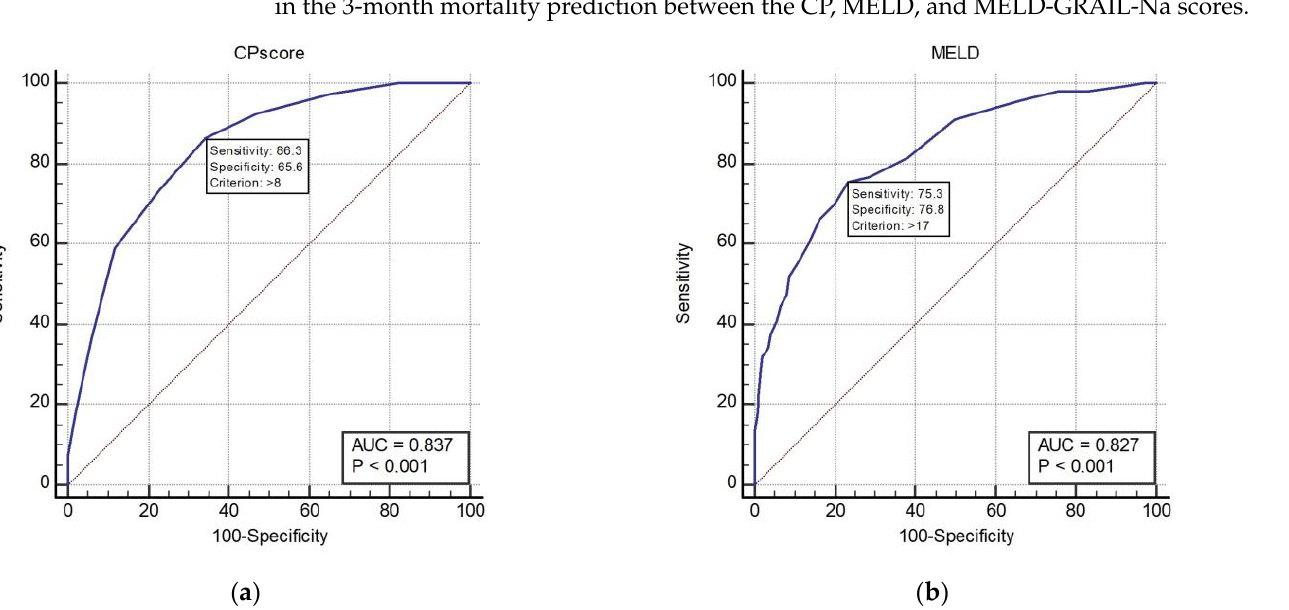
( d ) Figure 2. Receiver operating characteristic curves (ROC) and area under the ROC (AUROC) of pa- tients with total cirrhosis for 3 - month mortality. ( a ) CP score for 3 - month mortality, 0.837 (95% CI, 0.815–0.857); ( b ) MELD for 3 - month mortality, 0.827 (95% CI, 0.805–0.848); ( c ) MELD - GRAIL - Na for 3 - month mortality, 0.835 (95% CI, 0.814–0.856); ( d ) comparison of AUROC for 3 - month mortality between the CP, MELD, and MELD - GRAIL - Na scores. 3.5.3. One - Month Mortality Prediction in Patients with CP Classes B and C The AUROCs of the CP, MELD, and MELD - GRAIL - Na scores for 1 - month mortality in patients with CP classes B and C are shown in Figures 3a–c, respectively. The AUROC of the CP score was 0.782 ( p < 0.0001), that of MELD was 0.809 ( p < 0.0001), and that of MELD - GRAIL - Na was 0.825 ( p < 0.0001). A comparison of the AUROCs is shown in Fig- ure 3d. There was a significant difference between the CP score and the MELD - GRAIL - Na ( p = 0.0428), MELD, and MELD - GRAIL - Na scores ( p = 0.0493). Bayes- ian positive predictive value (PPV) and negative predictive value (NPV) of model/scores in predicting mortality were PPV 30.42, NPV 95.04 for CP score, PPV 30.34, NPV 95.7 for MELD and PPV 31.06, NPV 96.01 for MELD - GRAIL - Na. MELD - GRAIL - Na was high for both PPV and NPV.